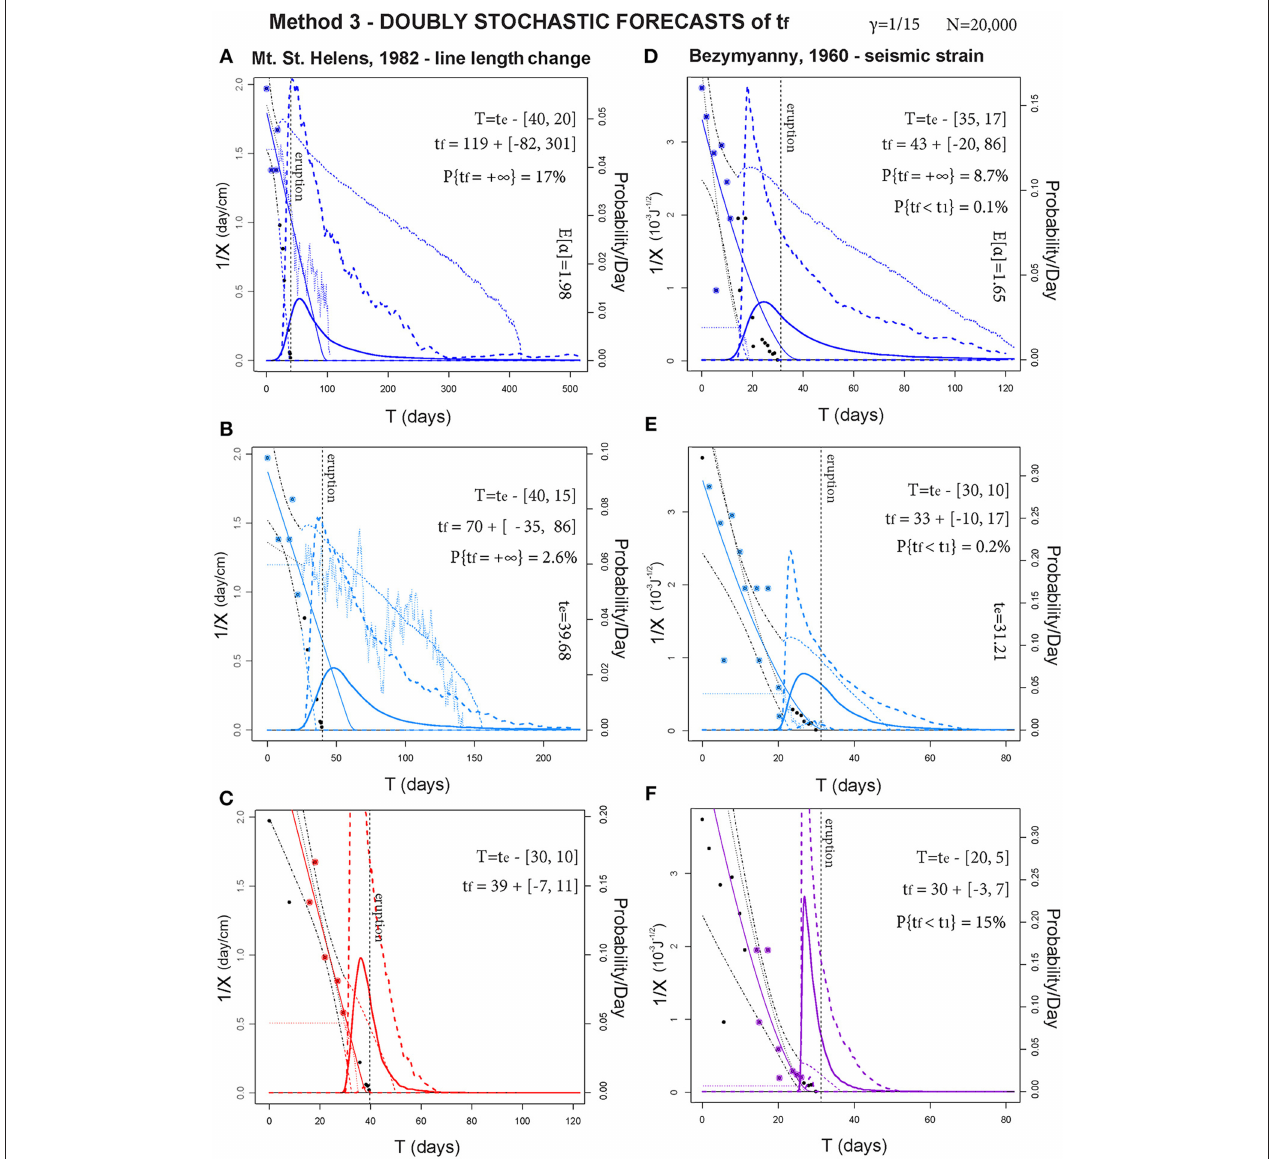
FIGURE 9 | Forecasts of t f based on Method 3. In (A–C) and (D–F) respectively, two examples are tested on three different time windows T . The bold line is g t bold dashed lines are its 5th and 95th percentile values. Thin dashed lines bound the 90 % confidence interval of the SDE paths, and a thin continuous line is the mean path. Thin dotted lines show examples of random paths. The points are inverse rate data, those in T are colored. A thin dashed line marks 1 / x 0 , and a dashed black line marks t e . The probability/day scale bar is related to g t and its percentile values. f